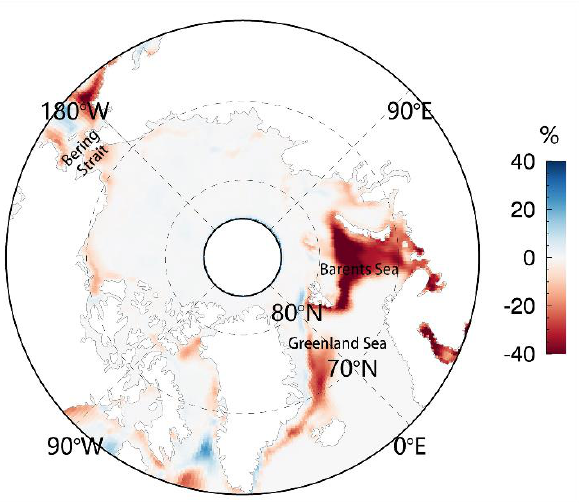
Figure 8. Difference map of composite analysis of SIC over the Arctic region based on meridional energy flux across 70 °N from ERA5.